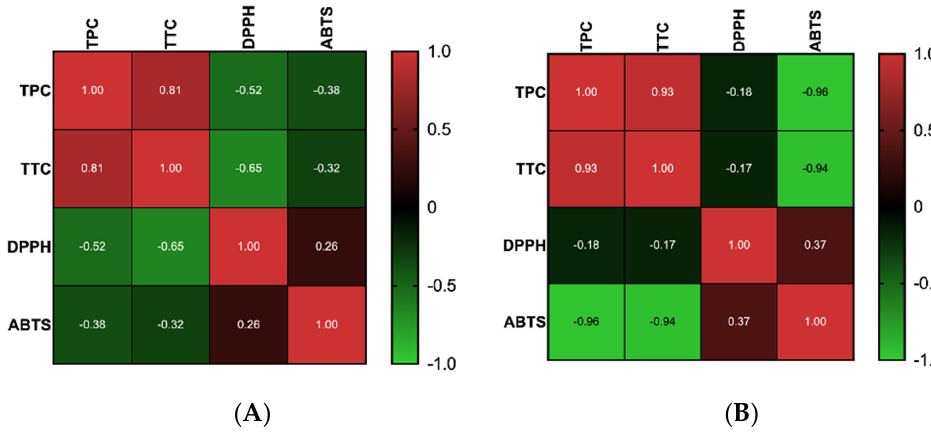
Figure 1. Pearson’s correlation coefficients among TPC, TTC, DPPH, and ABTS calculated for the extracts obtained by microwave-assisted extraction ( A ) and by ultrasound-assisted extraction ( B ).